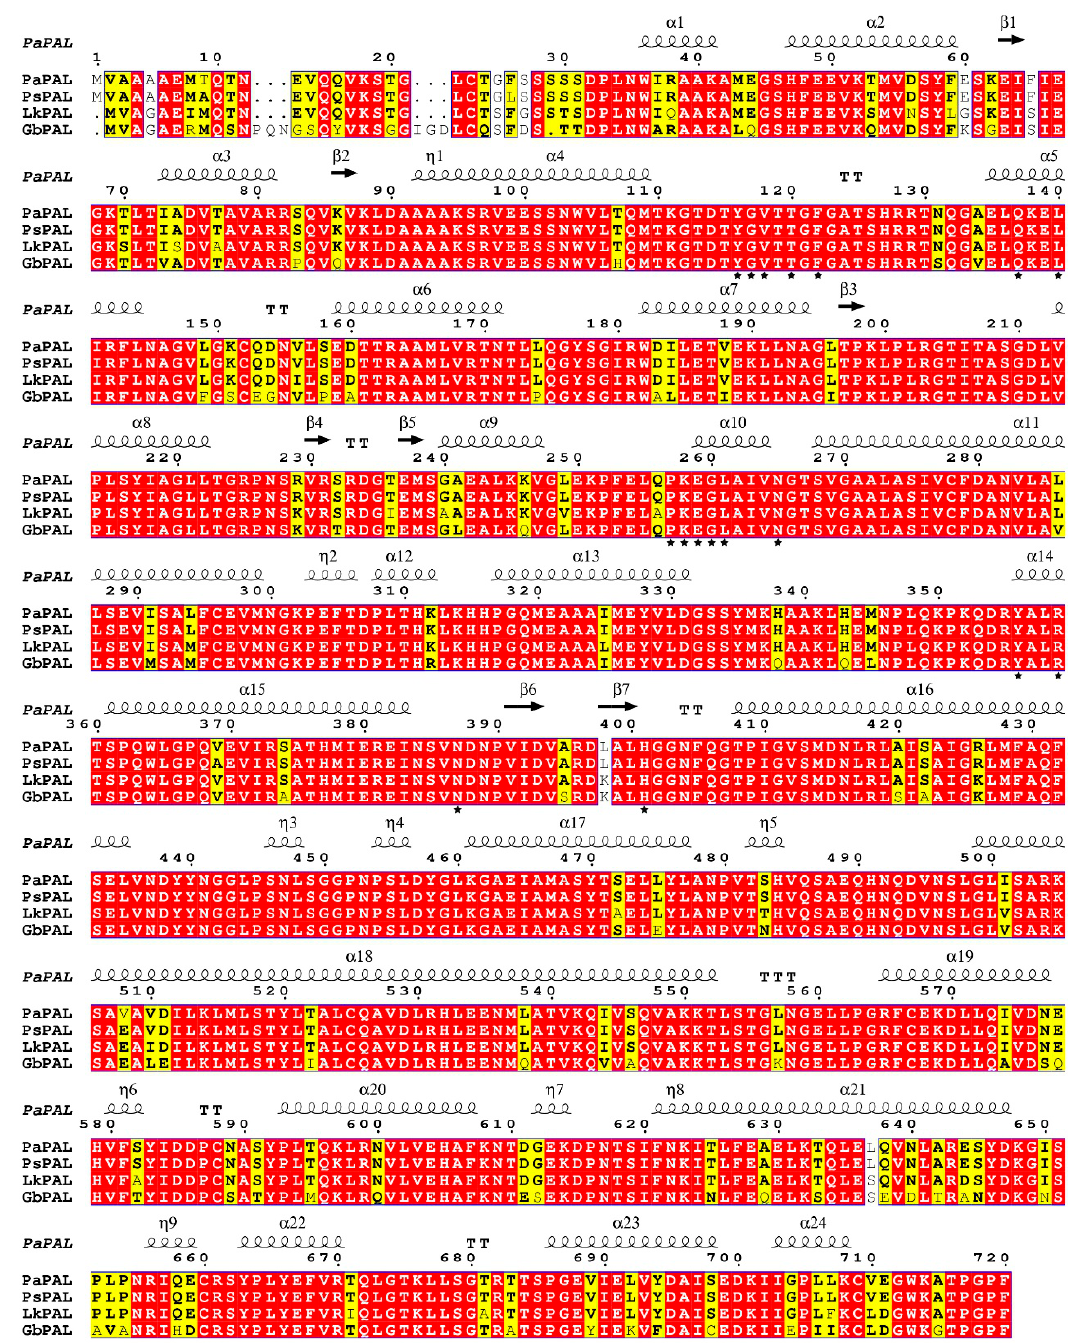
Figure 2. Multiple alignment of the deduced PaPAL protein with other plant phenylalanine ammonia-lyase (PAL) proteins. The sequences are from Picea sitchensis (PsPAL, ABK24709.1), Larix kaempferi (LkPAL, AHA44840.1) and Ginkgo biloba (GbPAL, ABU49842.1). Completely identical amino acid sequences are indicated with white words and red backgrounds. Highly conserved amino acid sequences are represented with black words and yellow backgrounds. Non-conserved amino acid sequences are shown with grey words and white backgrounds. α -Helices are displayed as large squiggles and η -helices as small squiggles. Strict β -turns are shown with TT letters and β -strands as arrows. Strictly conserved amino acid residues are shown as ★ .